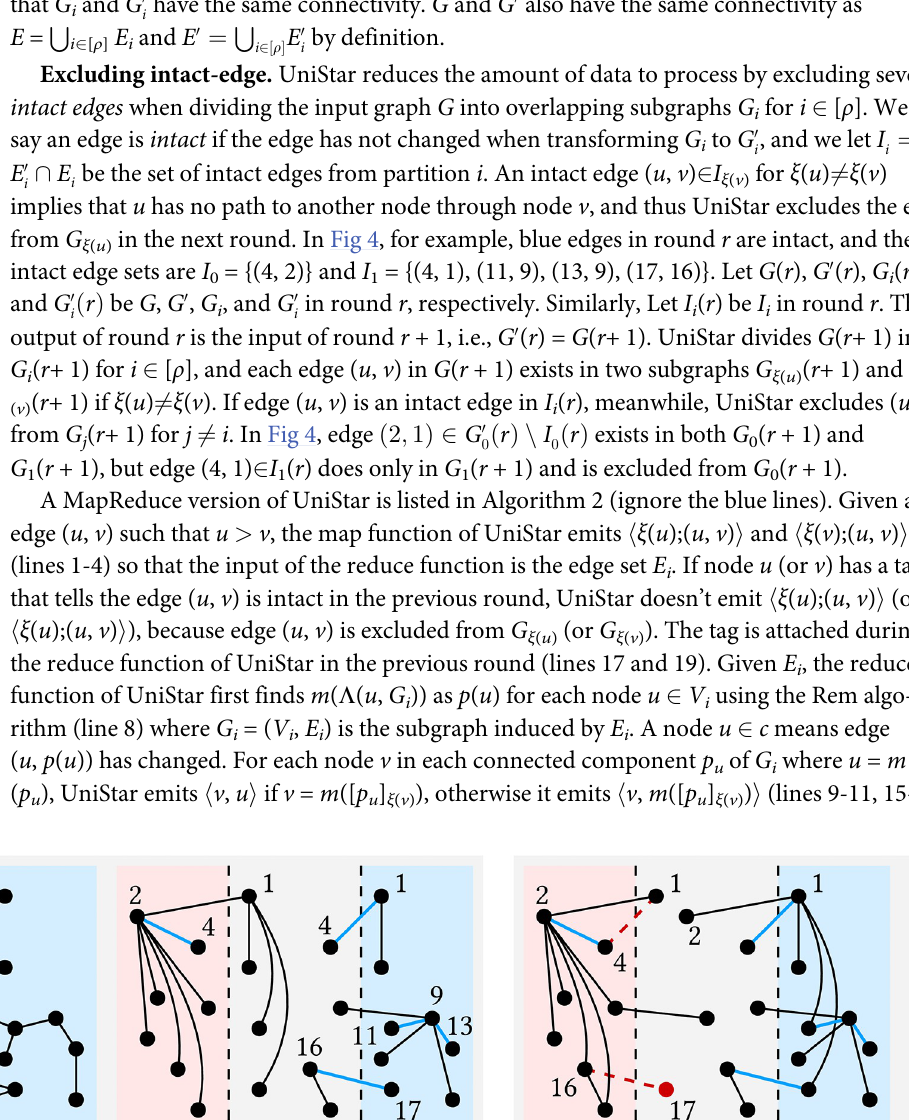
PLOS ONE | https://doi.org/10.1371/journal.pone.0277527 November30,